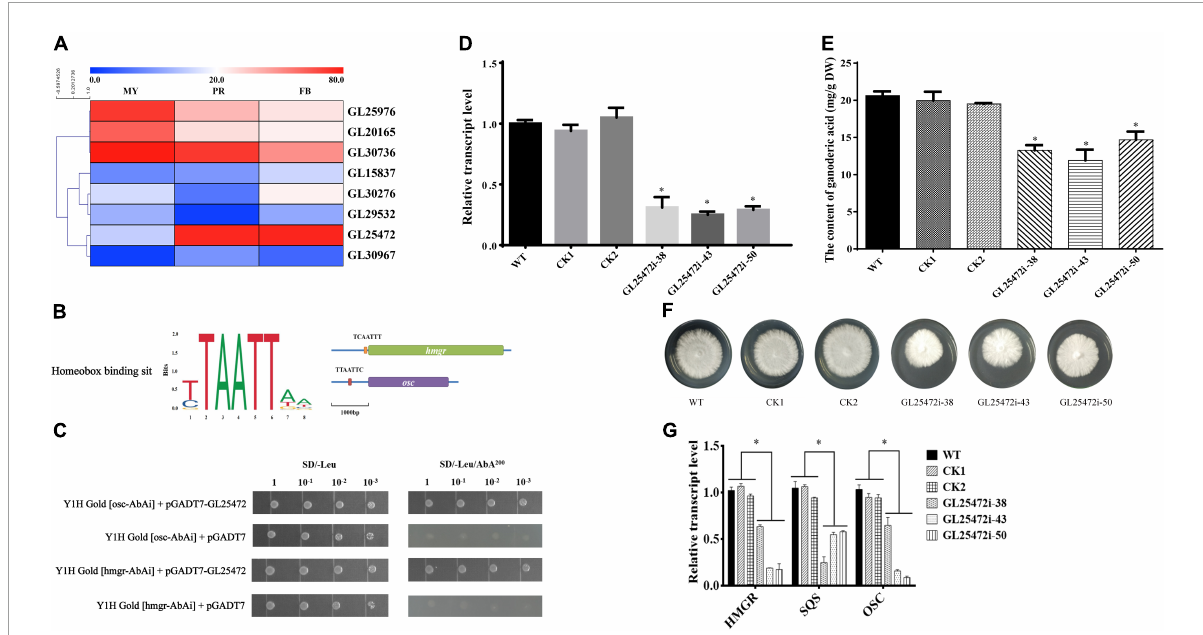
FIGURE5 The effects of homeobox transcription factors on ganoderic acid biosynthesis in G. lucidum. Panel (A) is the gene expression level of homeobox transcription factors. MY, mycelia; PR, primordia; FB, fruiting body. Panel (B) is the binding sit of homeobox transcription factor. The orange box (TCAATTT) and red box (TTAATTC) were CREs located in the promoter region of hmgr and osc. Panel (C) is yeast one-hybrid assay. Panels (D,E) are the relative transcript levels and GA contents of gene-silencing strains. Panel (F) the mycelial colony. Panel (G) the transcript levels of the genes encoding key enzymes. WT (wild-type), CK1 and CK2 (the empty vector controls), GL25472 (38, 43, 50) were gene-silencing strains. HMGR, 3-hydroxy-3-methylglutaryl-coenzyme A reductase; SQS, squalene synthase; OSC, 2,3-oxidosqualene-lanosterol cyclase. The histograms marked with ∗ represent significant differences; it indicates statistical significance ( p < 0.05) compared to